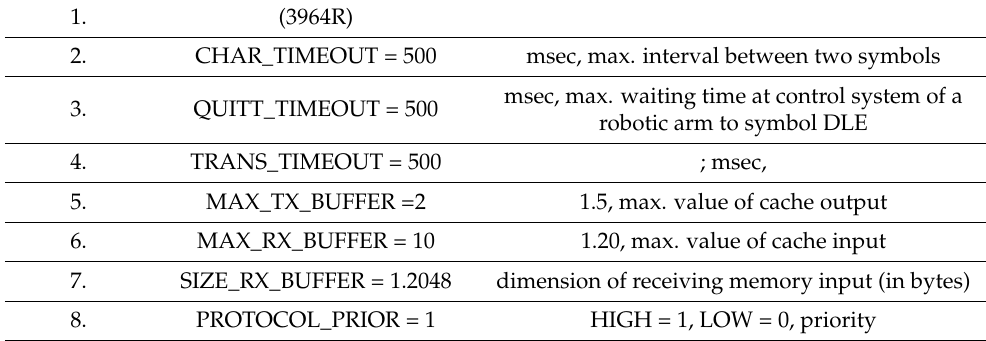
Table 2. Configuration of transmission protocol 3964R for the data transfer.